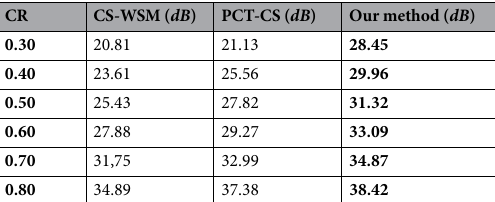
CR CS-WSM ( dB ) PCT-CS ( dB ) Our method ( dB )